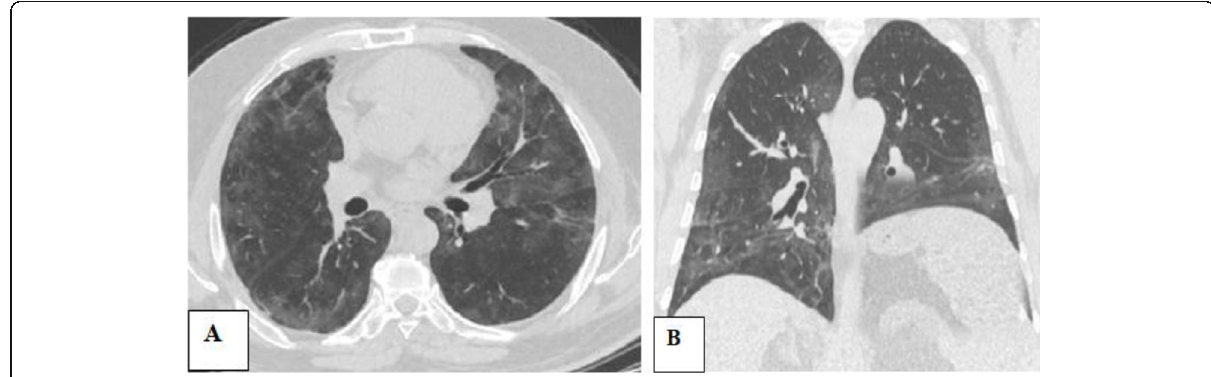
Fig. 4 Seventy-eight-year-old male patient, with a history of COVID-19 pneumonia, referred for initial CT evaluation with CT severity score 21. A, B Axial and coronal CT chest imaging respectively shows bilateral sub-pleural ground-glass patches and pulmonary consolidation with interlobar septal thickening. Incidental discovery of left-sided diaphragmatic paralysis. The patient died after 2 weeks from respiratory failure